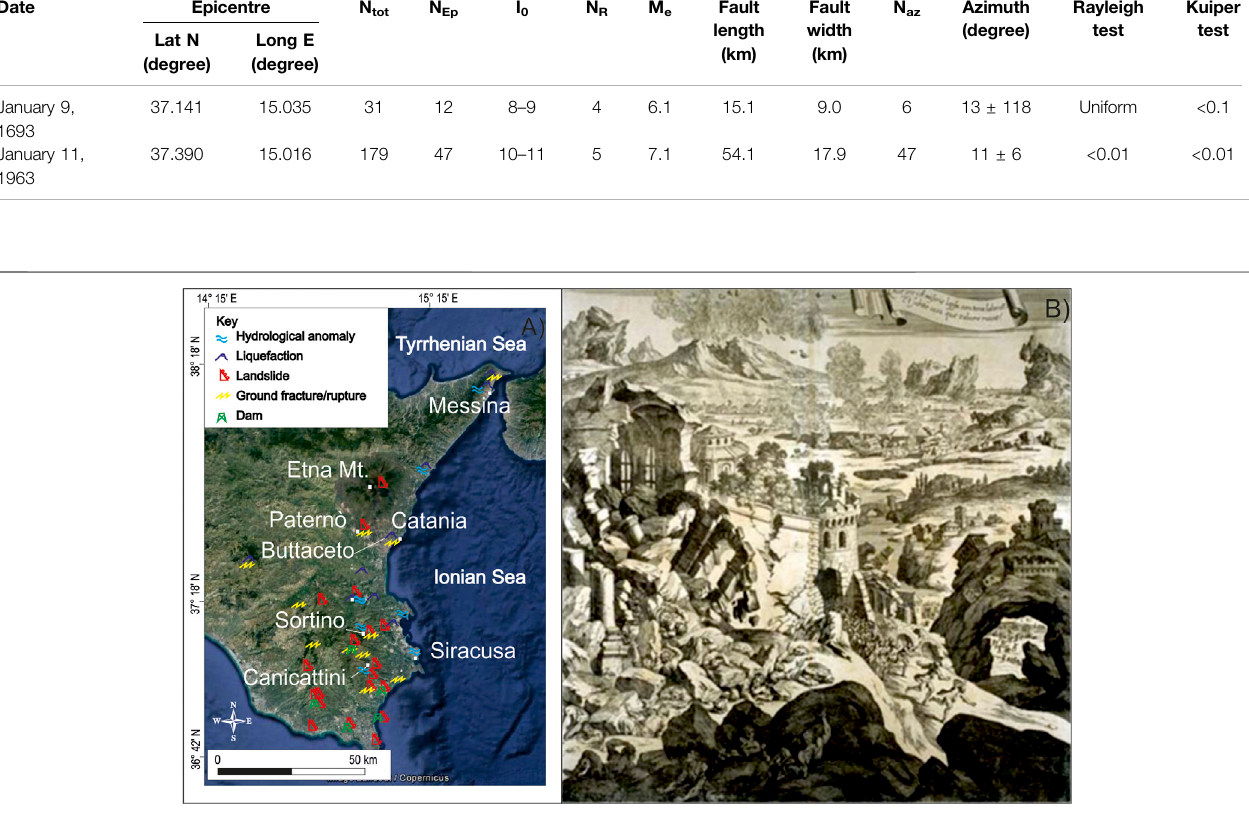
Frontiers in Earth Science |